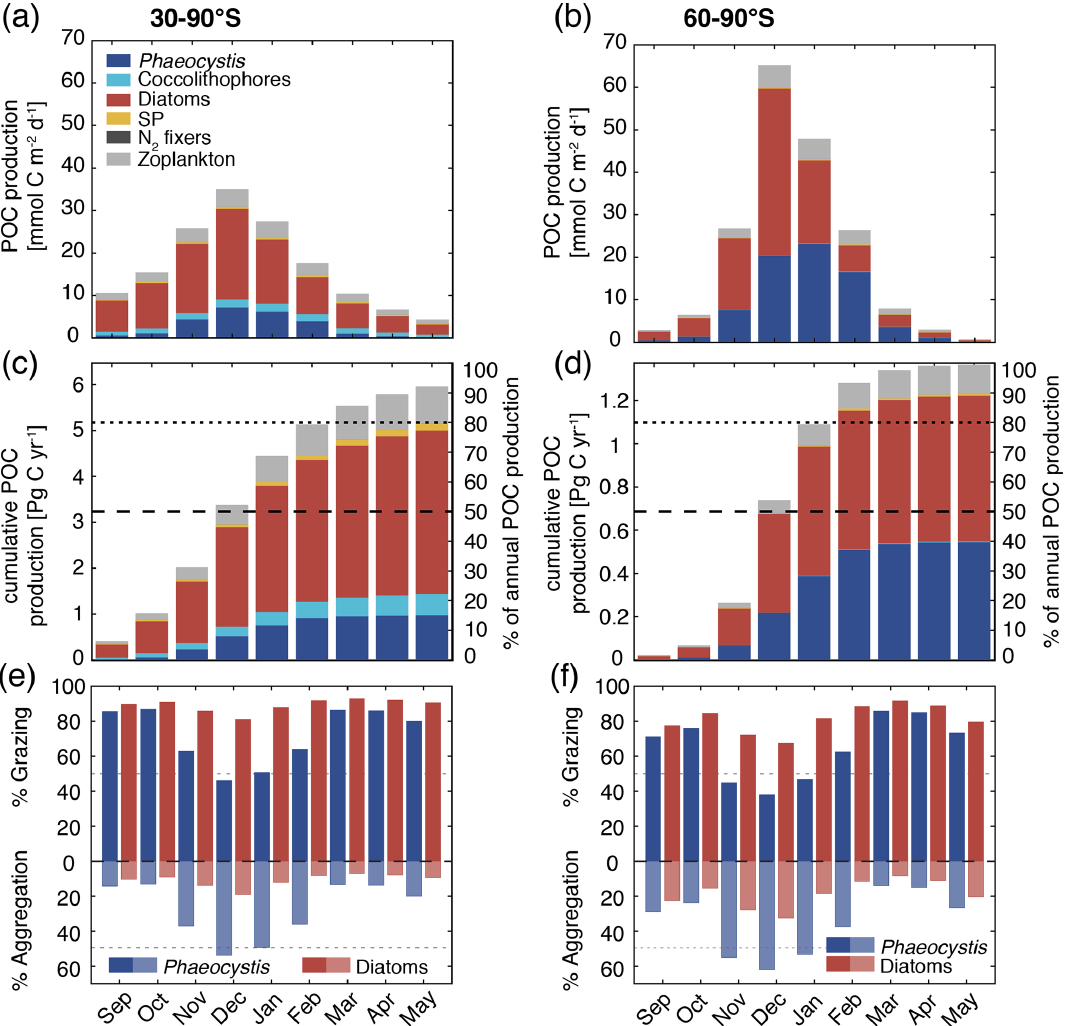
Figure 7. Simulated vertically integrated production of particulate organic carbon (POC) (a, b) as a function of time (mmolCm − 2 d − 1 ), (c, d) cumulative over time (absolute production in PgCyr − 1 on the left axis and relative to annually integrated production on the right axis), and (e, f) as a function of time via grazing and aggregation. The colors correspond to the different PFTs in ROMS-BEC, and the panels correspond to averages or integrals over 30–90 ◦ S (left) and 60–90 ◦ S (right), respectively. The results for the Ross Sea are comparable for those between 60–90 ◦ S (see Fig.